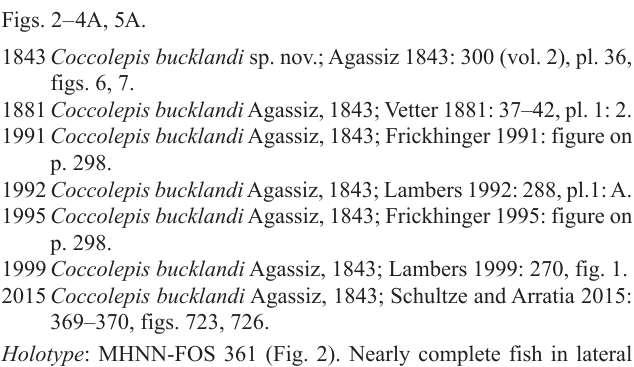
Holotype : MHNN-FOS 361 (Fig. 2). Nearly complete fish in lateral view, missing a portion of its tail and the anteriormost part of the cra-